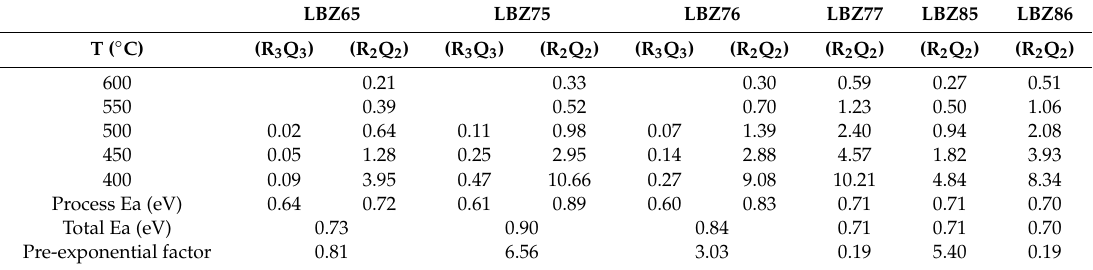
Table 3. Cathode area specific resistance (ASR) in Ω · cm 2 from 400 to 600 ◦ C at pH 2 O = 0.03 atm, total and per process activation energies and pre-exponential factor for the di ff erent LBZ